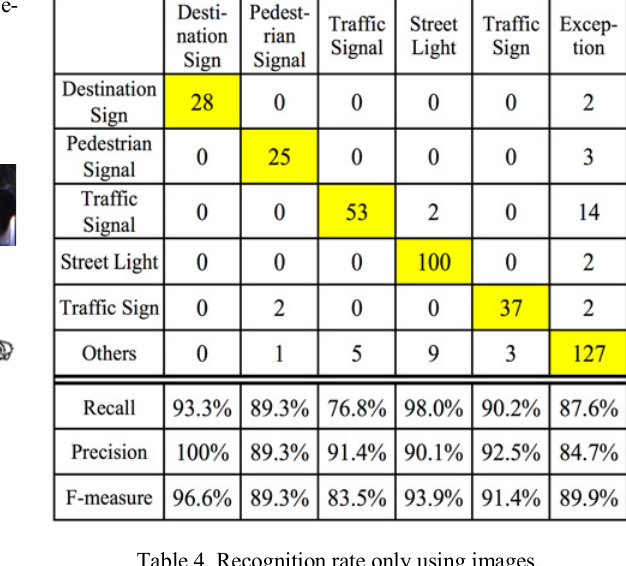
Table 4. Recognition rate only using images.